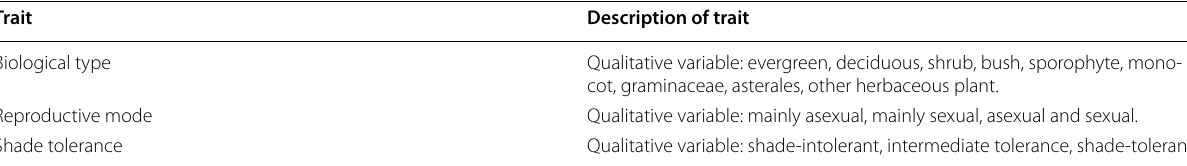
Table 1 Individual environmental performance traits that were included in the analysis Trait Description of